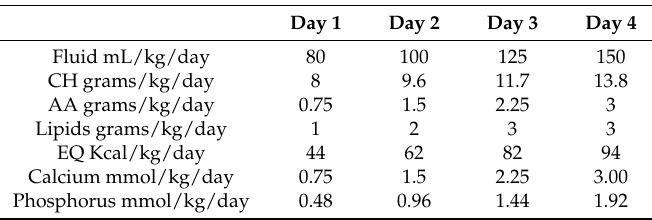
Table A1. Standard parenteral nutritional intake.